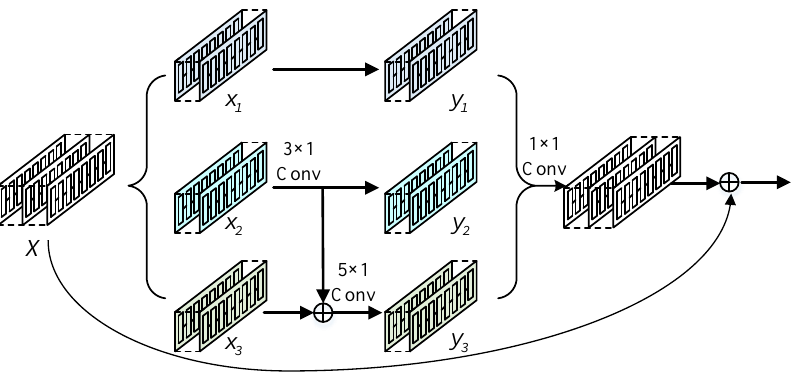
Figure 4. Multi-scale fusion residual module structure diagram.